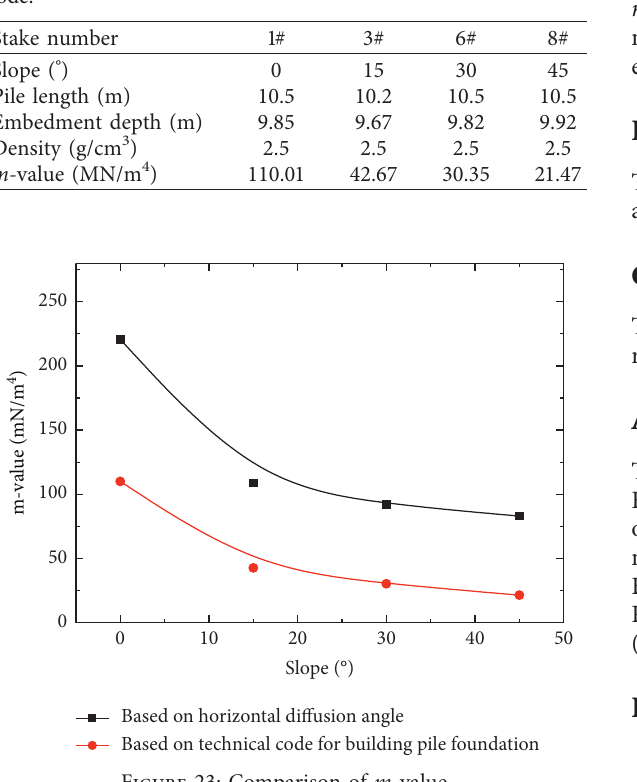
Figure 23: Comparison of m